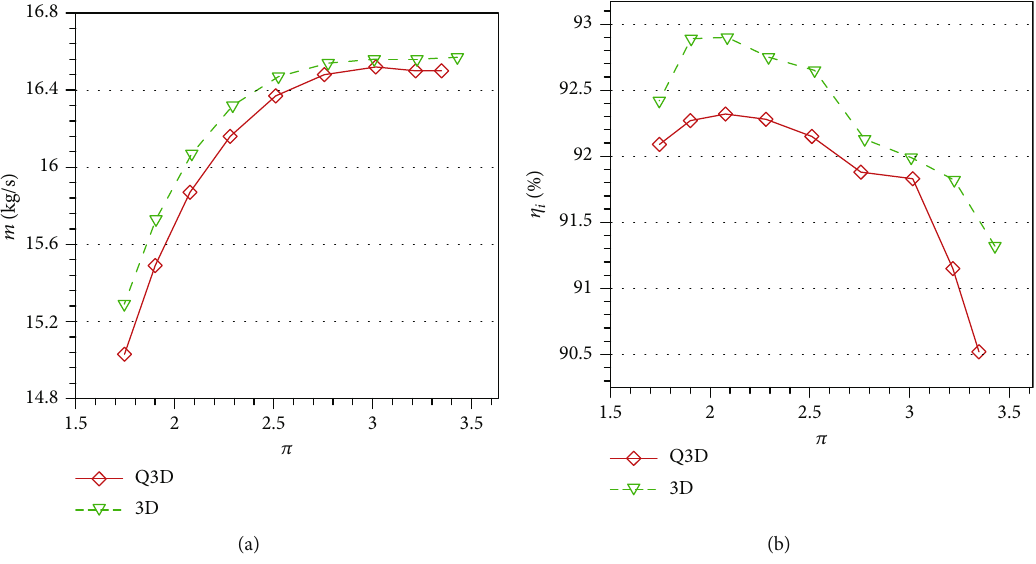
Figure 15: Characteristic curves of the two-stage turbine: (a) mass fl ow rate; (b) e ffi ciency. Table 5: Overall performance results of the single-stage turbine. Parameter Q3D 3D _ m /(kg/s) 38.15 37.68 π 3.657 3.663 η i /% 90.81